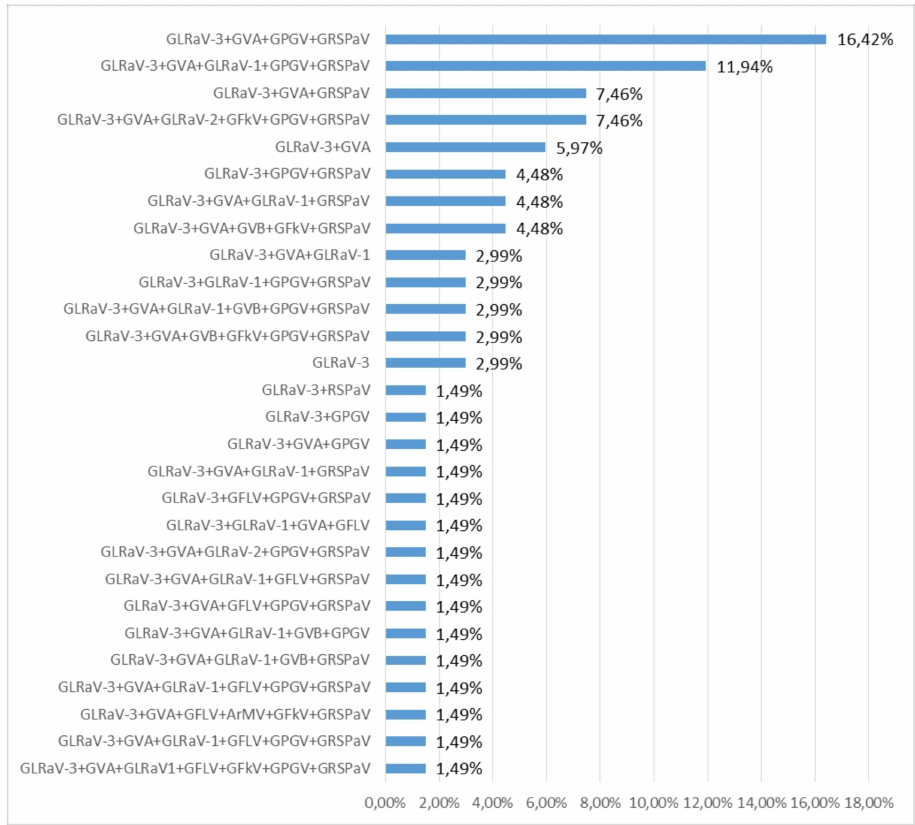
Figure 2. Percentages of different virus combinations infecting tested grapevine samples. The majority of the samples (26.76%) were infected with four different viruses (Figure 3), while the highest number of different viruses, seven, was detected in one sample of cv Vugava. When looking at the average number of viruses infecting different cultivars, the highest value was recorded in cv Babi´c and the smallest in cv Plavac mali (Figure 4). A higher sensitivity in diagnostics was accomplished using multiplex PCR in